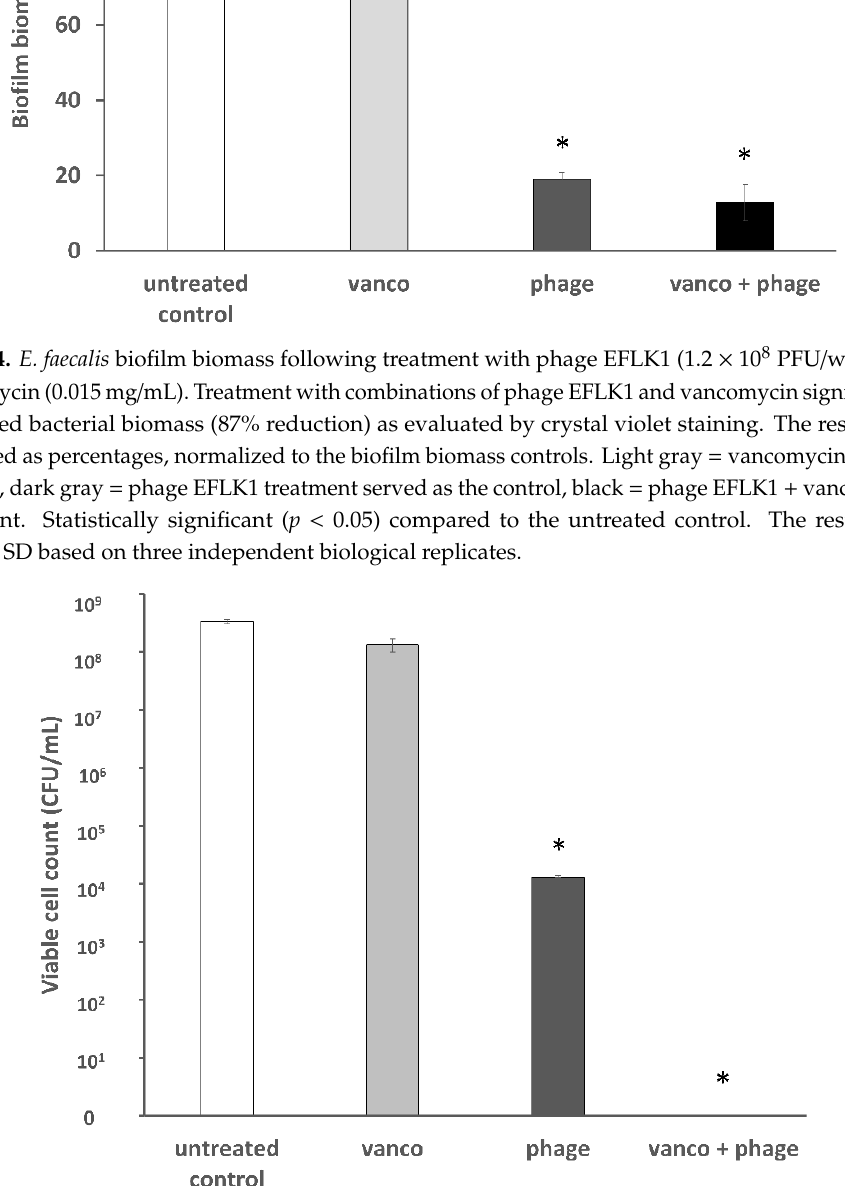
Figure 5. VRE 72-h biofilm viable counts following a combined treatment of phage EFLK1 (1.2 × 10 8 PFU / well) and vancomycin (0.015 mg / mL). Combining vancomycin and phage EFLK1 caused an eight logs reduction in the CFU / mL of the bacterial biofilm, bacteria were below the limit of detection. Phage EFLK1 caused four log reductions, and vancomycin caused less than a log reduction. Light gray = vancomycin treatment alone, dark gray = phage EFLK1 treatment alone, served as the control, black = phage EFLK1 + vancomycin treatment. Statistically significant ( p < 0.05) compared to the untreated control. The results are mean ± SD based on three independent biological replicates.